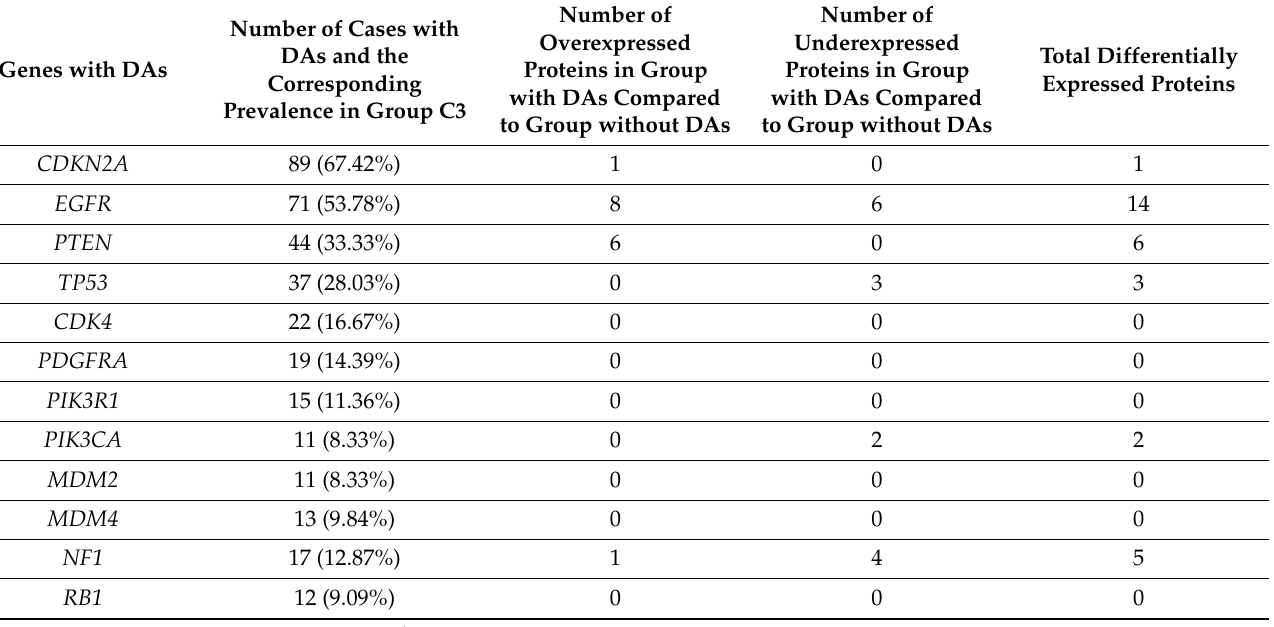
Table 4. Prevalence of cases with driver alterations in 12 common driver genes along with their associated counts of differentially expressed proteins (overexpressed, underexpressed and total counts). The analyses were performed on the C3